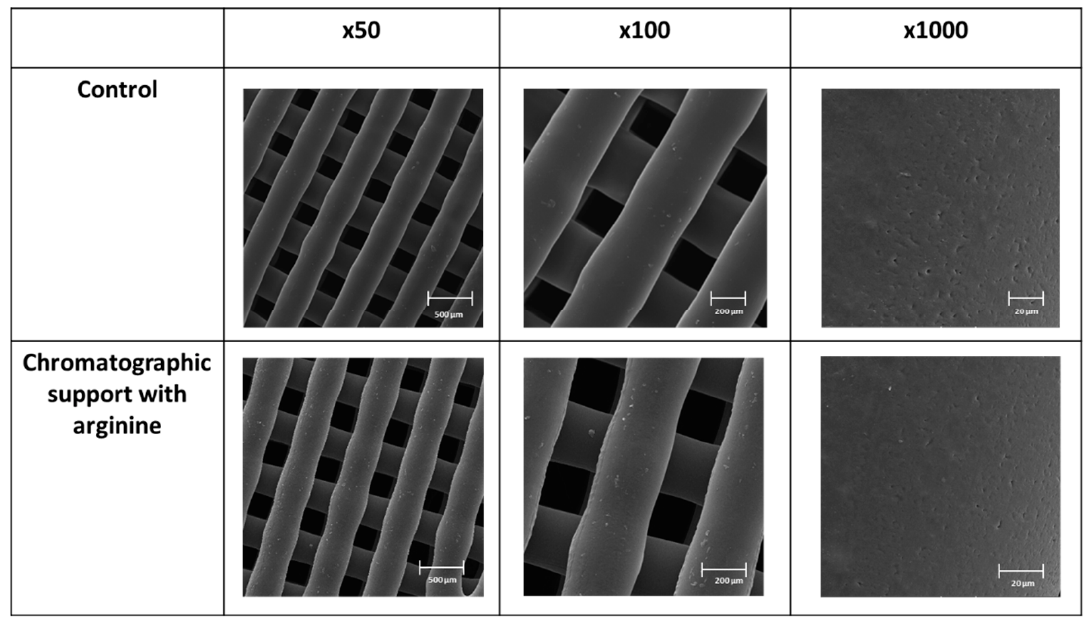
Figure 3. SEM analysis (with magnifications of 50, 100, and 1000×) of the 3D-printed PCL structure before and after the immobilization process.